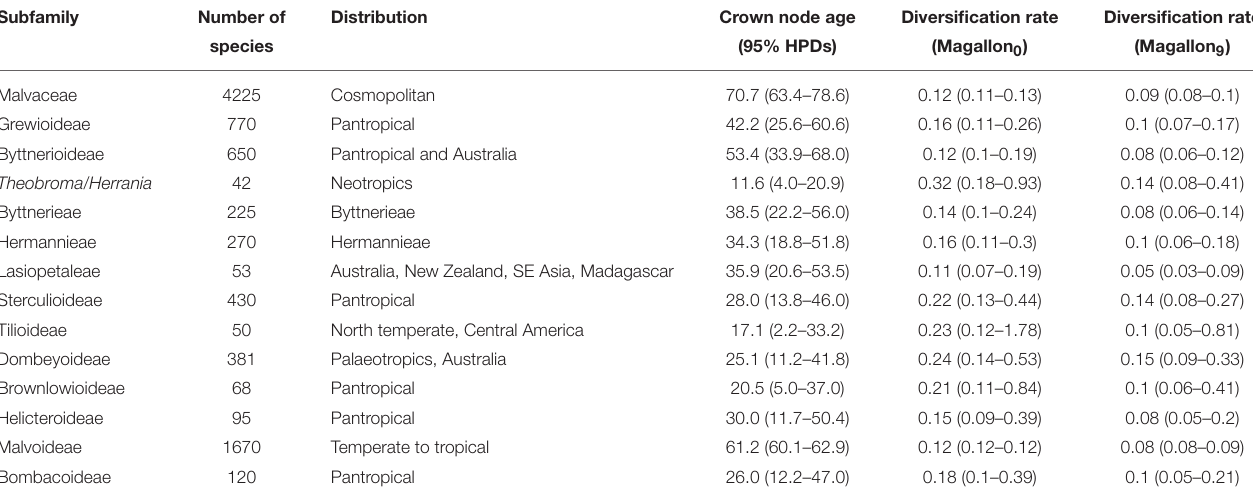
TABLE 2 | Diversification rates of subfamilies of Malvaceae and selected clades in Byttnerioideae. Subfamily Number of